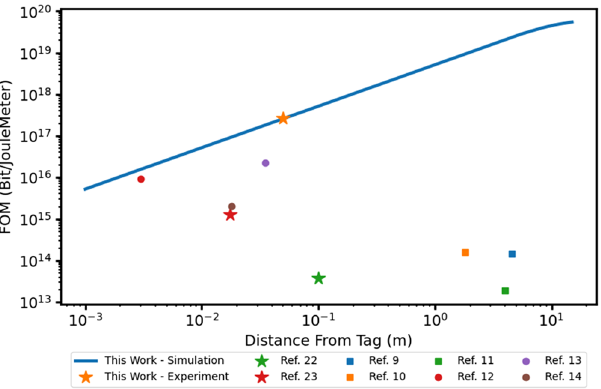
Figure 3. Comparison of RF and optical interlink platforms with the device presented in this work. Circular markers are near-field coupled devices. Squares are far-field RF devices. Stars are optical communication